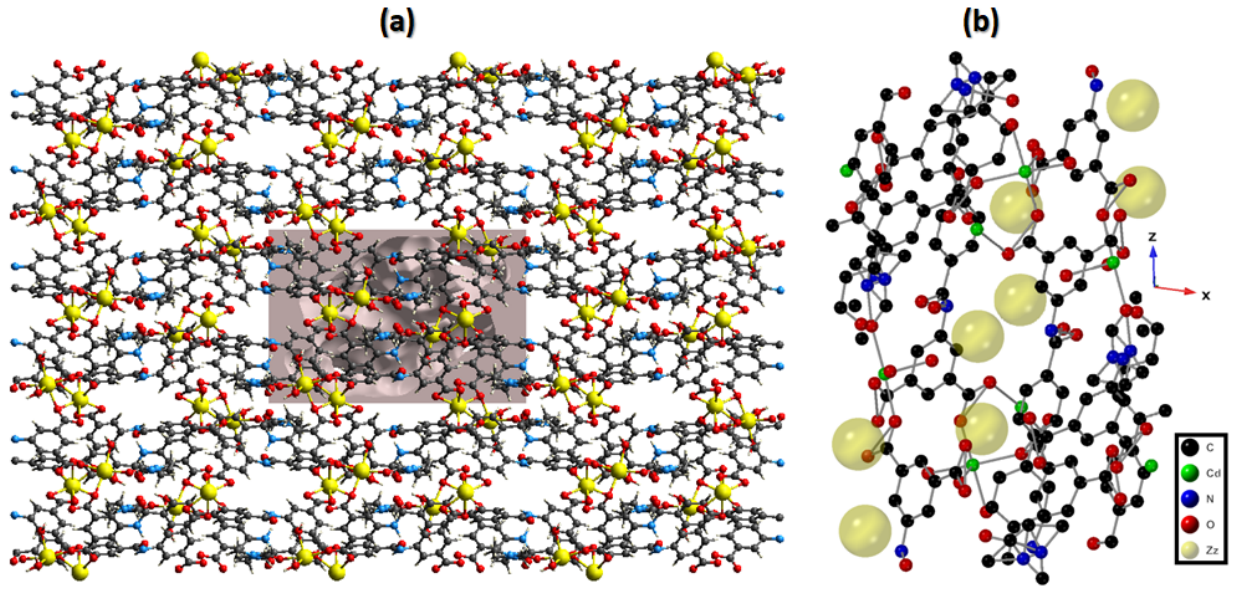
Figure 9. ( a ) Graphical representation of voids analysis along bc crystallographic plane for CdMOF ( b ) cavities shown as dummy atoms